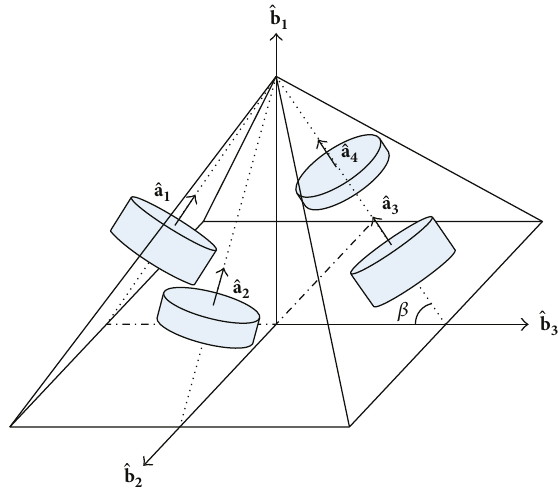
Figure 1: Spacecraft with four reaction wheels in a pyramid con fi